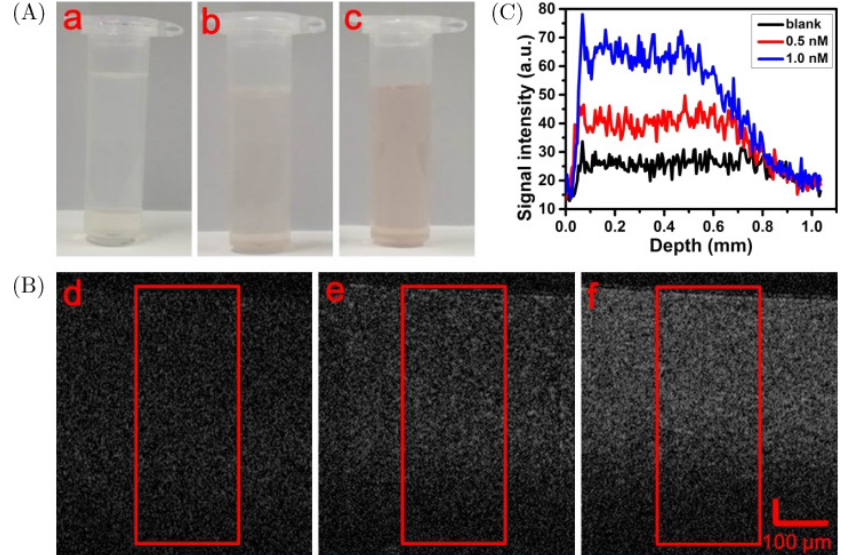
Fig. 5. (A) Photograph of agar in the absence (a) and presence of di®erent concentrations of PEG-GNRs tissue phantom, i.e., (b) 0.5nM, (c) 1.0 nM; (B) 2D OCT images in the absence (d) and presence of di®erent concentrations of PEG-GNRs, i.e., (e) 0.5 nM and (f) 1.0 nM; (C) Attenuation curves of OCT signal of ROIs in